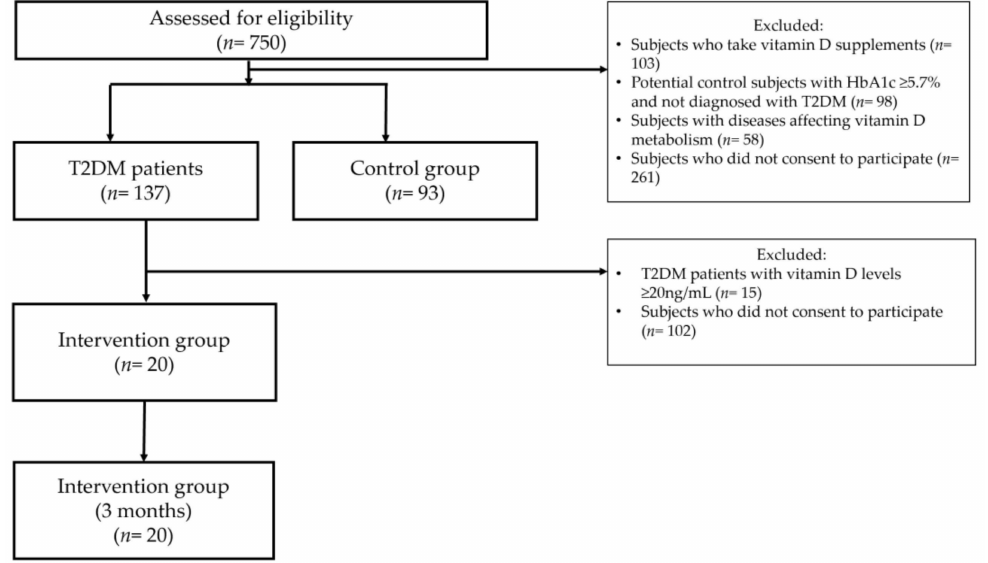
Figure 1. Flow chart summarizing the study design with relevant exclusion criteria. Two hundred and thirty participants were recruited for the case-control part of this study. The number of patients diagnosed with T2DM was 137, whereas the number of disease-free controls was 93. T2DM was diagnosed according to the American Diabetes As- sociation (ADA) guidelines. All patients with T2DM were recruited from the endocrinology clinics of KAUH. These patients were actively treated for T2DM at the time of recruitment. Patients were included in the T2DM group if they were clinically diagnosed with T2DM, regardless of their HbA1c levels at the time of